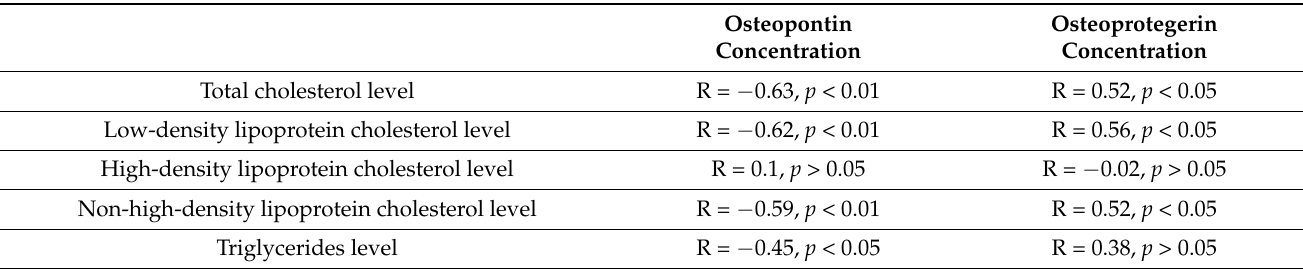
Table 3. Correlation between cholesterol fraction levels and levels of osteopontin (OPN) and os- teosteoprotegerin